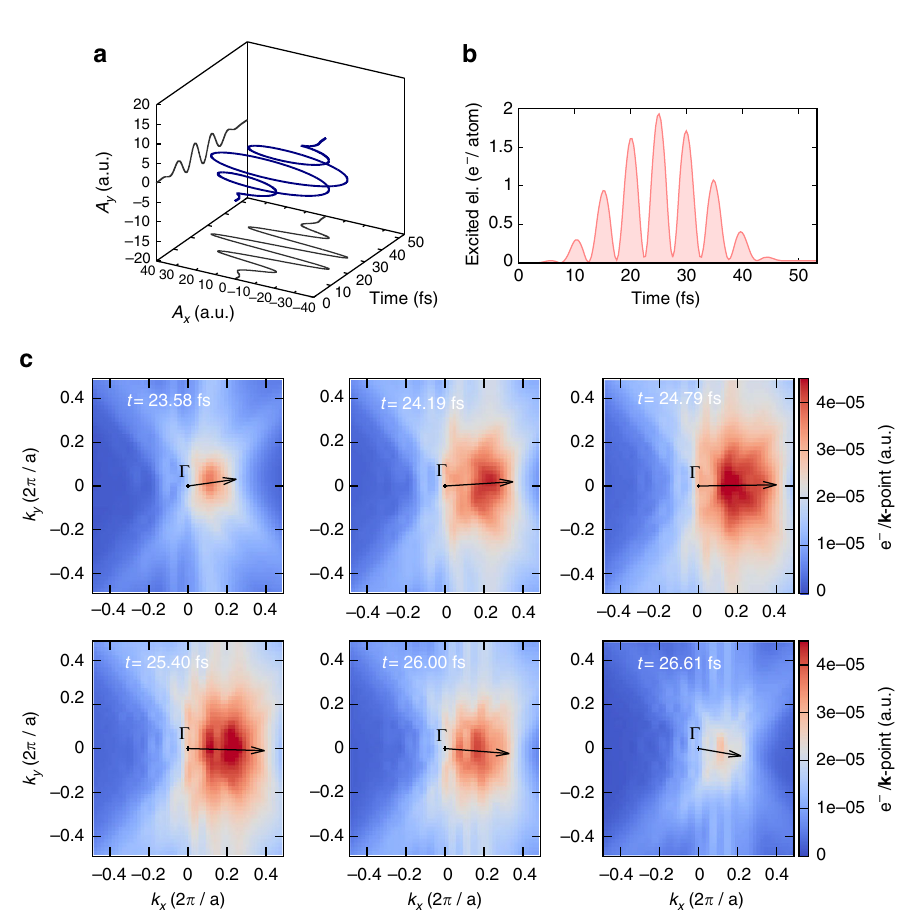
Fig. 3 TDDFT simulations of the subcycle dynamics of the excited electrons. Simulations are performed for bulk Si, around the maximum of the laser vector potential, in the k z = 0 plane. a The left-handed applied vector potential, with an ellipticity of ϵ = 0.1. b Number of electrons excited to the conduction bands during the laser pulse. c Momentum space resolved subcycle dynamics of the excited electrons. The black arrow indicates the direction and strength of the applied vector potential. The number of excited electrons (displayed as colormap) is computed by projecting the time-evolved wavefunctions on the ground-state Kohn – Sham wavefunctions (see “ Methods ”